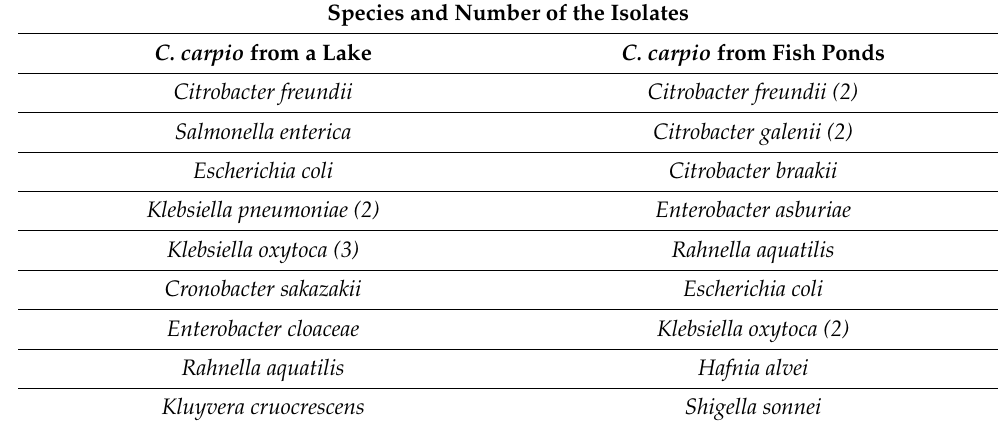
Table 2. Species of Enterobacteriaceae identified from the wild and agricultural carp.